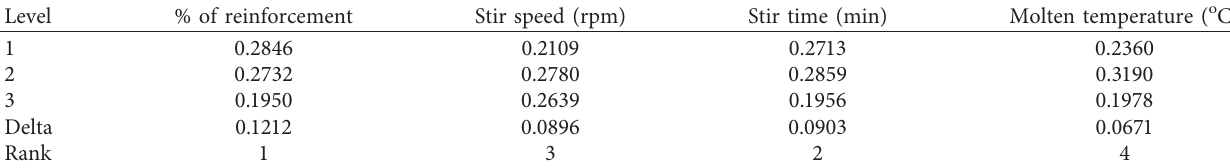
Table 4: Response table for means (wear test).